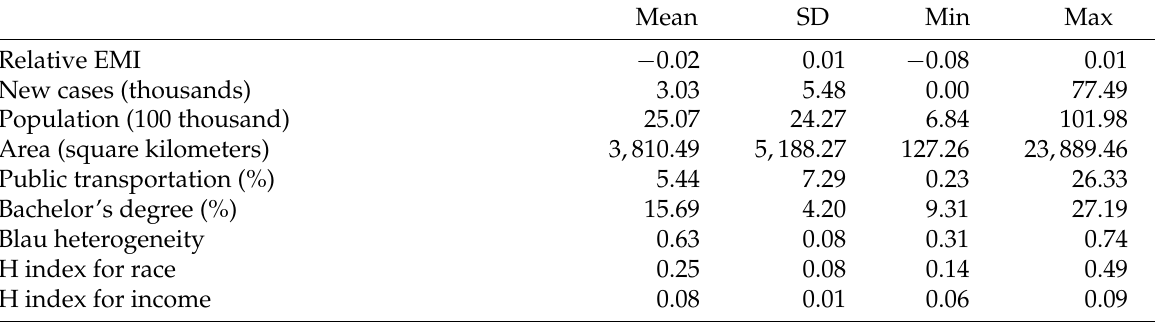
Table 1: Summary